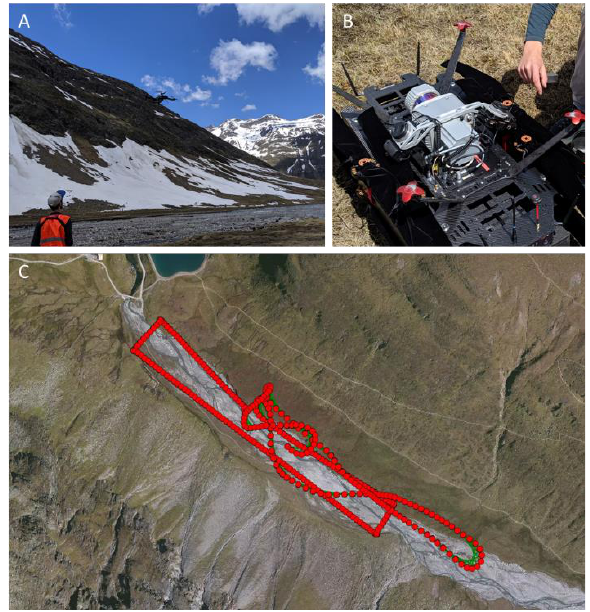
Figure 5. RiCOPTER flight mission (A), sensor configuration with two side-looking looking cameras (B) and flight path